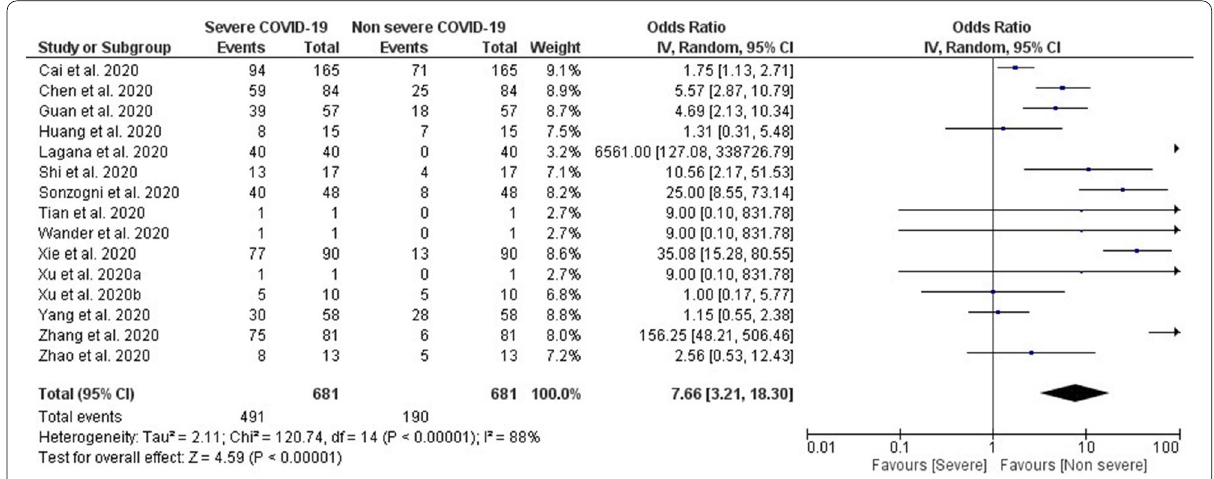
Fig. 2 Forest plot showing the association between severity of COVID-19 and liver